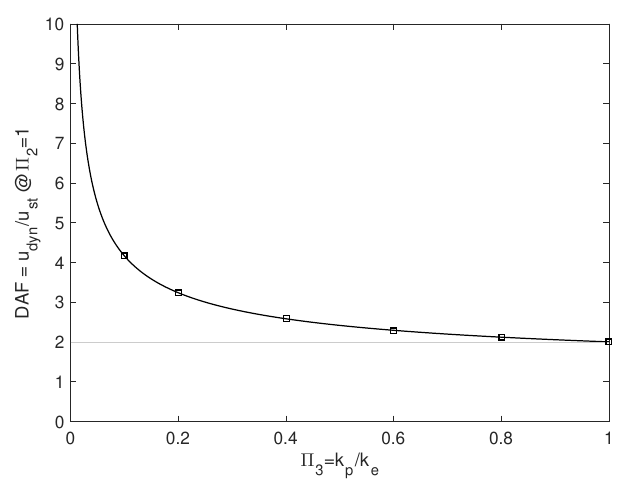
Figure 6. Dynamic amplification factor for various stiffness ratios Π 3 in the range ( 0;1 ] for Π = 1. The grey line corresponds to DAF=2. Squares represents the DAF obtained through the 2 numerical